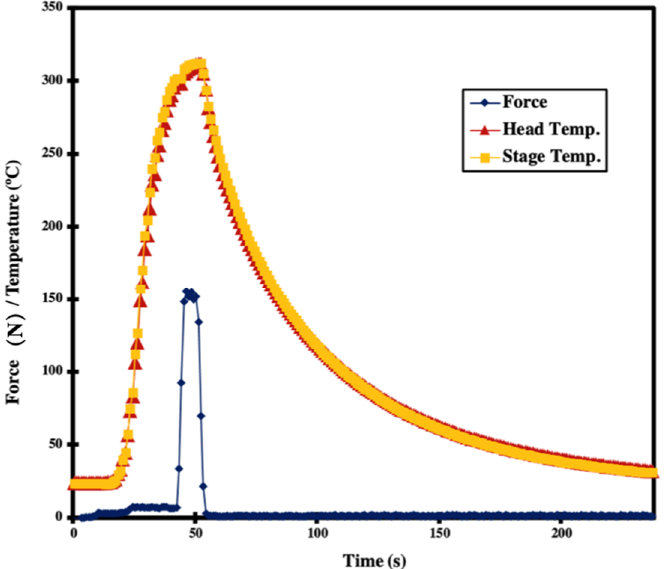
Figure 6. Process profile of temperature and bonding force vs. bonding time in the first step with an applied bonding force of 47 MPa.